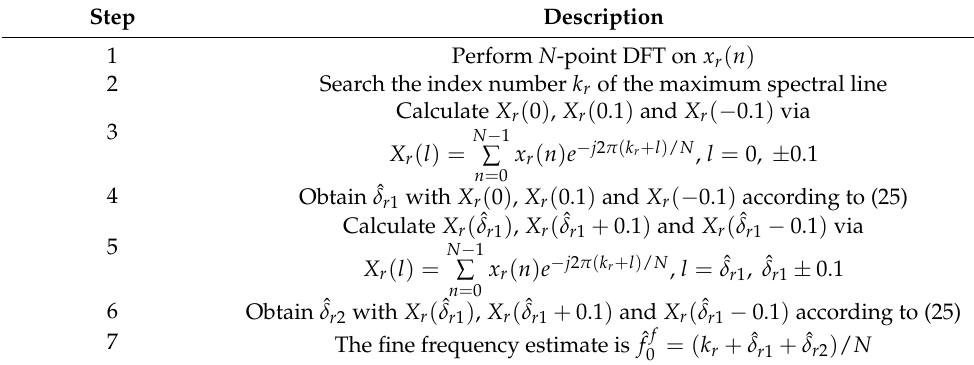
Table 2. Fine frequency estimation step.